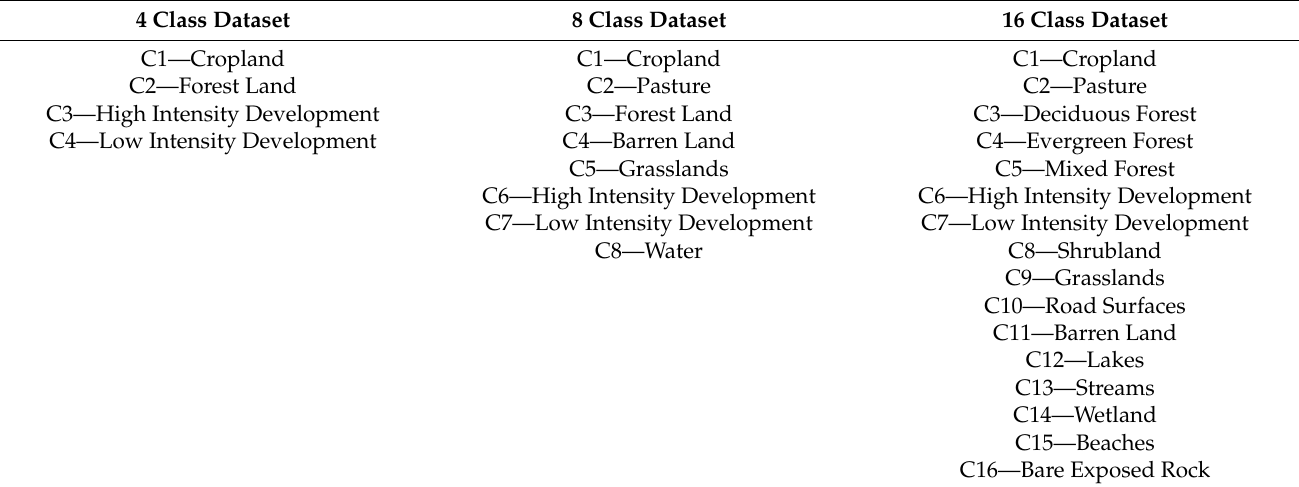
Table 2. LC classes featured in the 4, 8, and 16-class datasets.